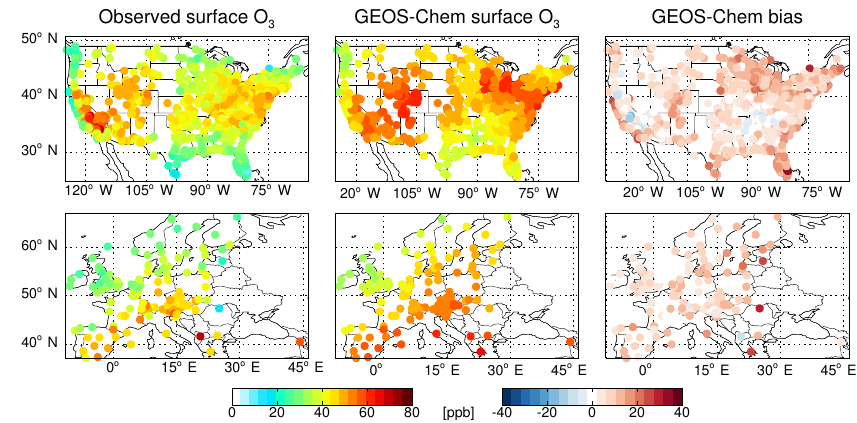
Figure 2. For both (top row) AQS network sites over the US and (bottom row) EMEP network sites over Europe: comparison of mean daytime (08:00–20:00 local time) (left column) observed and (middle column) GEOS-Chem simulated surface ozone concentrations for summer (JJA) 2010. Bias (simulated-observed) shown in right